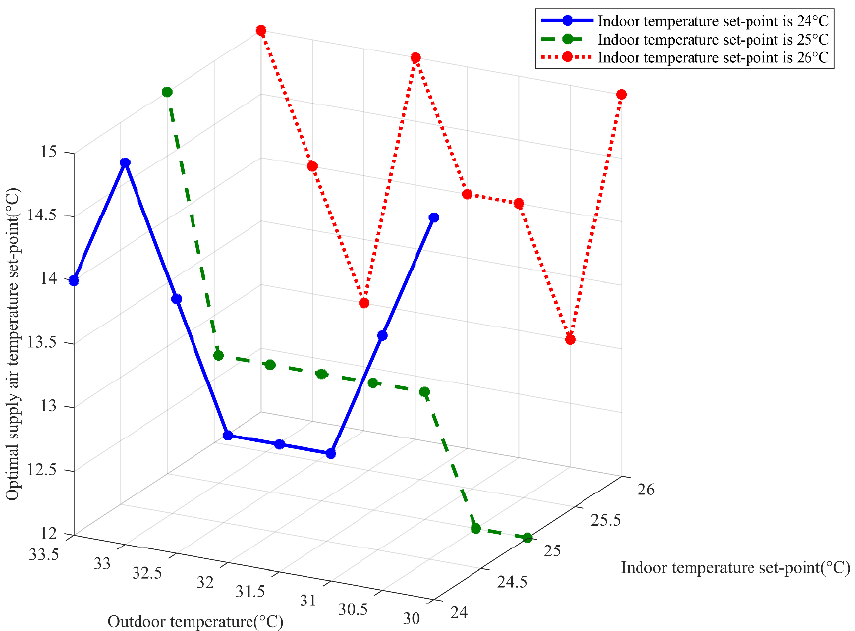
Figure 13. Relationship between outdoor temperature and supply air temperature under different indoor temperature set-points.